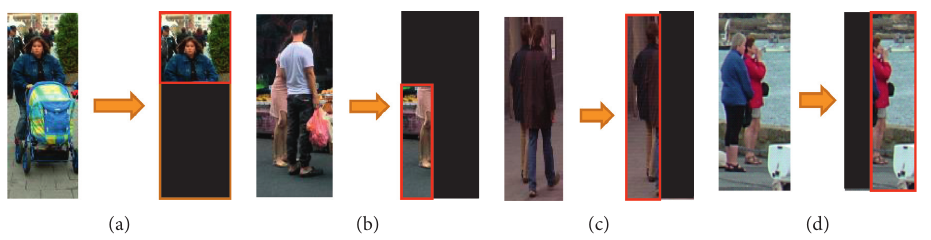
Figure 1: Example representation of the visible partial occluded parts. (a) Upper body part. (b) Occluded lower body part. (c) Left body part. (d) Occluded right body